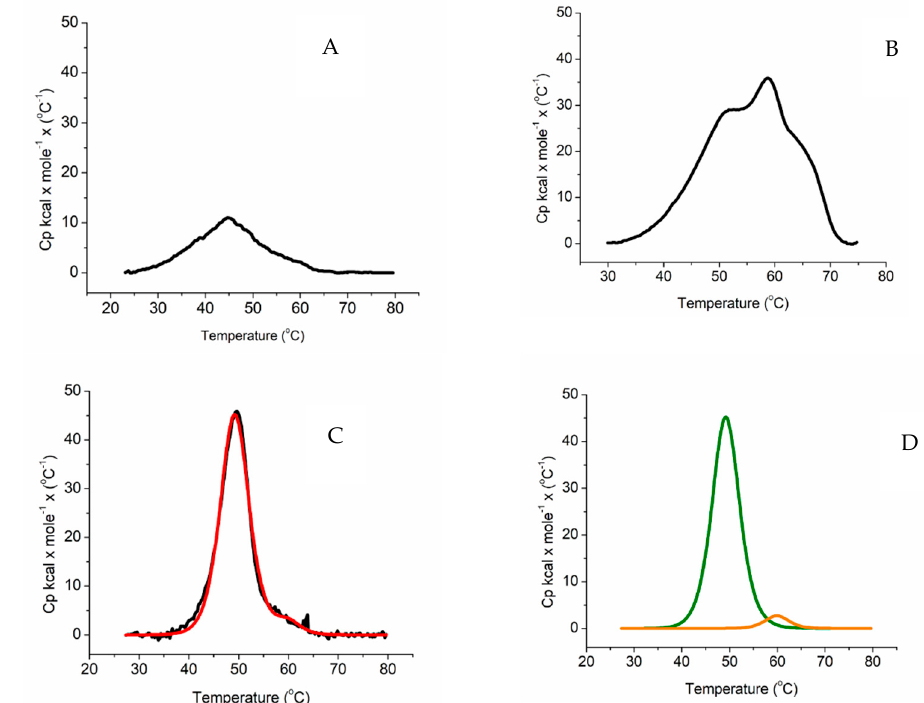
Figure 2. Thermograms of ( A ) aromatase, ( B ) CYP3A4, and ( C ) BMR. All measurements were car ‐ ried out at scan/rate of 90 °C/h. Black lines are the experimental curves, the red line is the fitting of the experimental curve applying a non ‐ two ‐ state denaturation model. ( D ) Deconvolution BMR. The green line is the deconvolution of the first peak and the orange line is the deconvolution of the second peak.